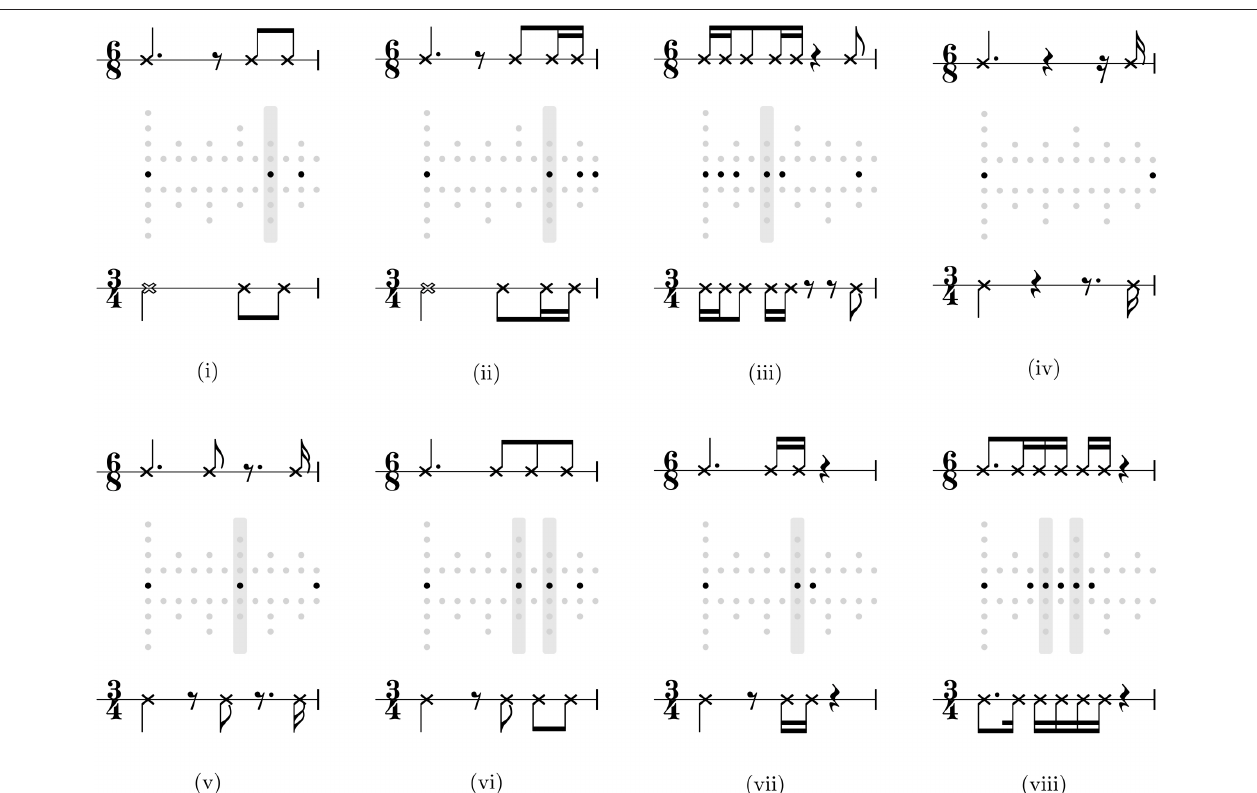
FIGURE 6 | The full set of rhythms interpreted as non-anacrustic 3/4 rhythm by a model with a 3/4 inferential bias and a non-anacrustic 6/8 rhythm by a model with a 6/8 inferential bias. Each rhythm is shown in dot notation between a compound 6/8 metrical grid (above) and a 3/4 simple metrical grid (below). The gray bars highlight onsets that fall on beats with different theoretical saliencies in both interpretations. Score transcriptions of the rhythms in 6/8 and 3/4 are shown above and below the